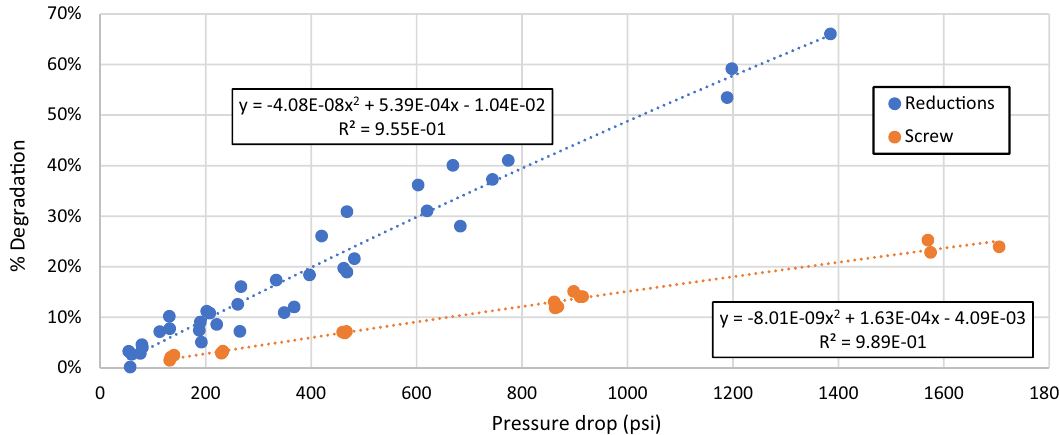
Fig. 13 Relation between the percentage of degradation and the pressure drop obtained experimentally